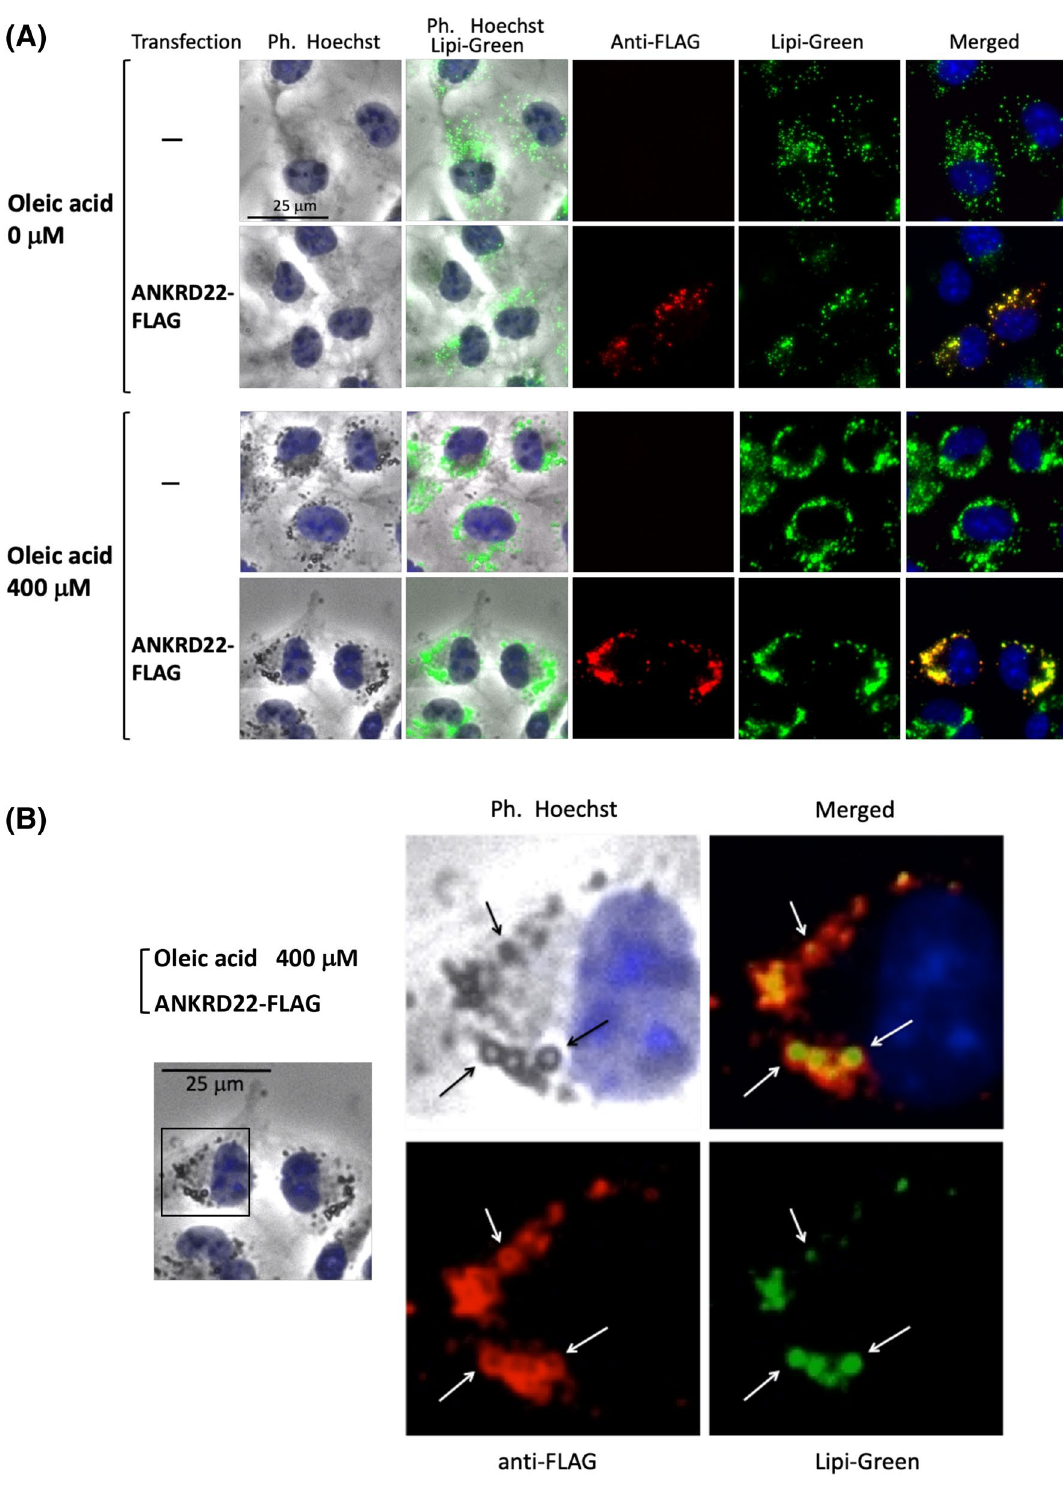
Figure 3. ANKRD22 specifically localized to LD. To confirm the specific localization of ANKRD22 to LD, LD formation in non-transfected COS-1 cells or COS-1 cells transfected with ANKRD22-FLAG cDNA was induced by incubating cells with a medium containing 400 µM oleic acid (OA) overnight, and the cells were then stained with Lipi-Green. Thereafter, the intracellular localization of ANKRD22-FLAG was assessed by immunofluorescence analysis. For this analysis, non-transfected COS-1 cells or transfected COS-1 cells incubated overnight in the absence of OA were used as control cells. The experiments were repeated 3 times and the similar results were obtained. A representative data was presented. ( A ) Phase contrast and fluorescence images obtained by immunofluorescence analysis of control (non-OA-treated) COS-1 cells and COS-1 cells treated with 400 µM OA. ( B ) Close-up images of phase contrast and fluorescence images of COS-1 cells transfected with ANKRD22-FLAG cDNA treated with 400 µM oleic acid (OA) shown in ( A ). Close-up images of the area surrounded by a black box in the left panel were